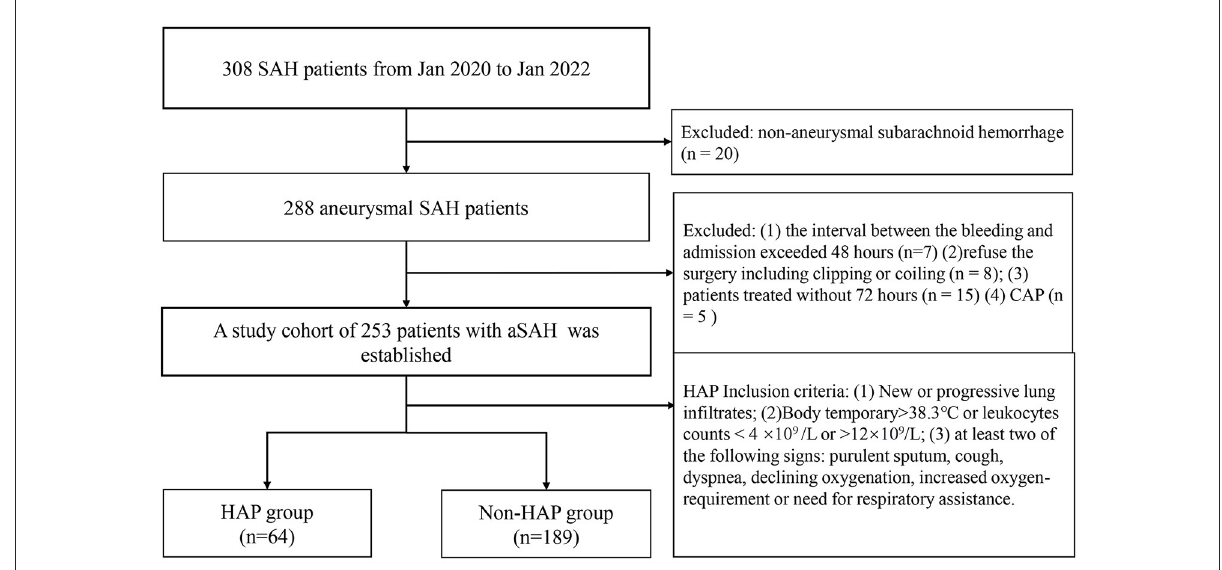
FIGURE1 The flow chart of patient selection. SAH, subarachnoid hemorrhage; CAP, community-acquired pneumonia; HAP, hospital-acquired